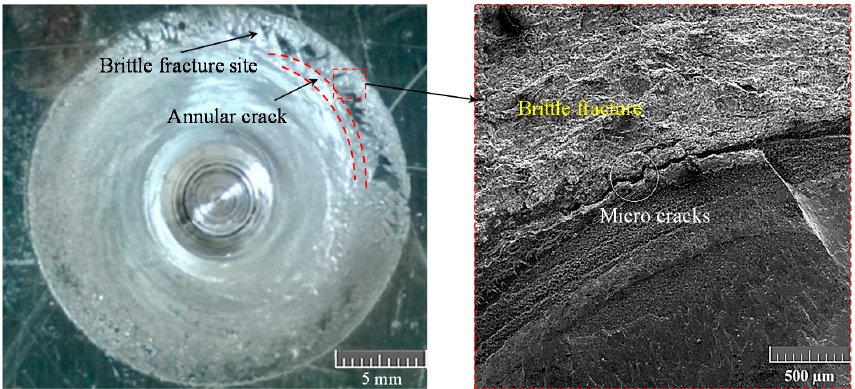
Figure 19. A typical lap-shear failure in the FSSW joint.